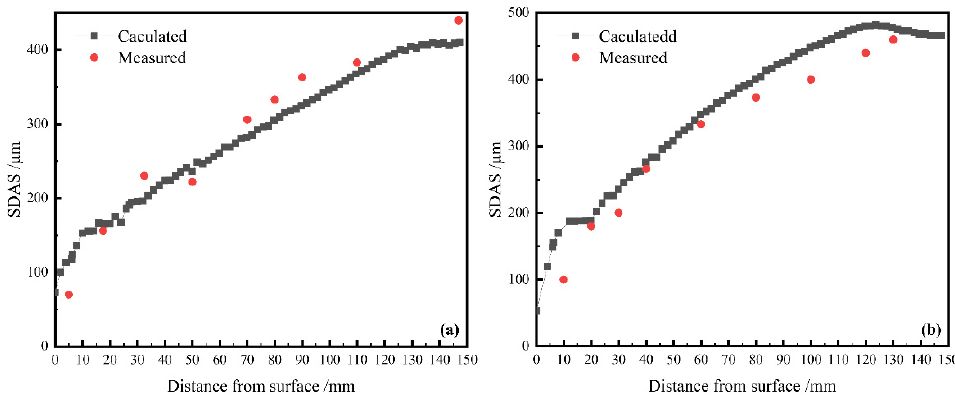
Figure 10. Comparison between calculated and measured SDAS: ( a ) S-4; ( b ) S-5.